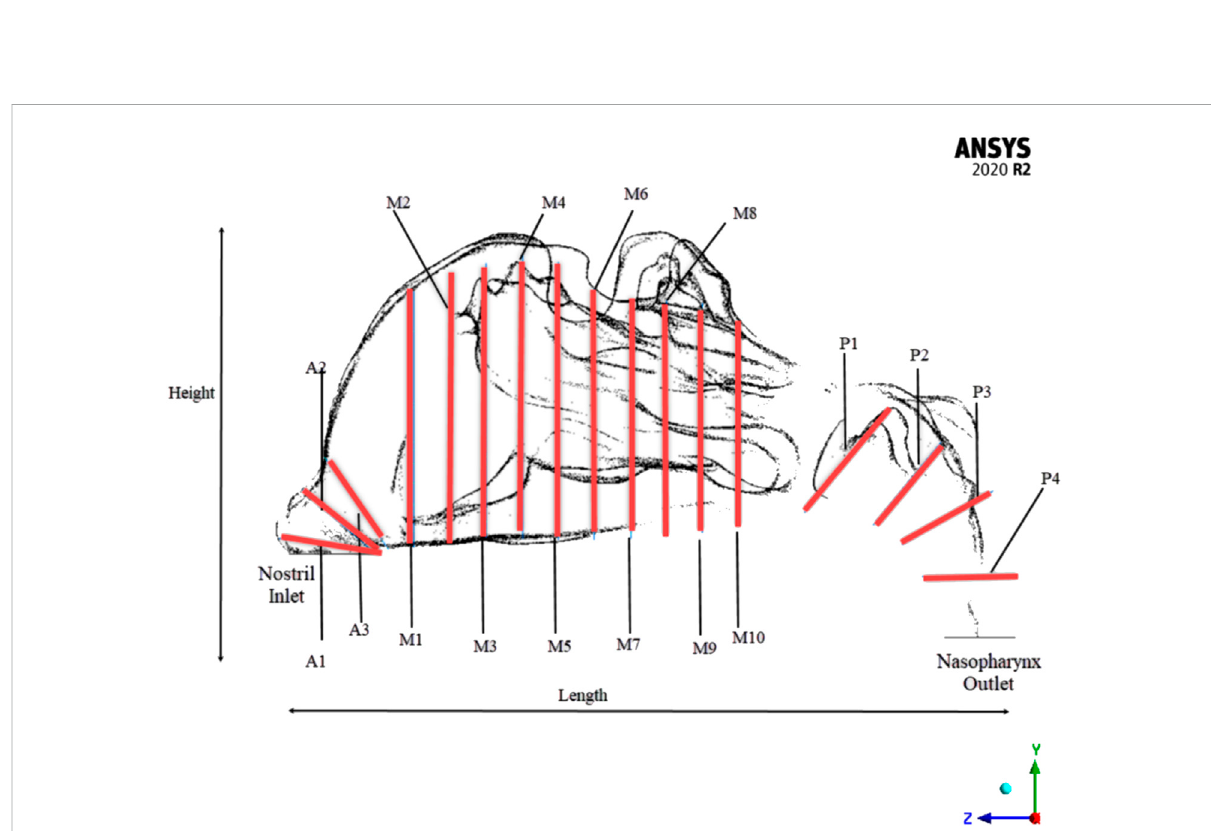
FIGURE 2 Cross-sectional planes in the adult nasal